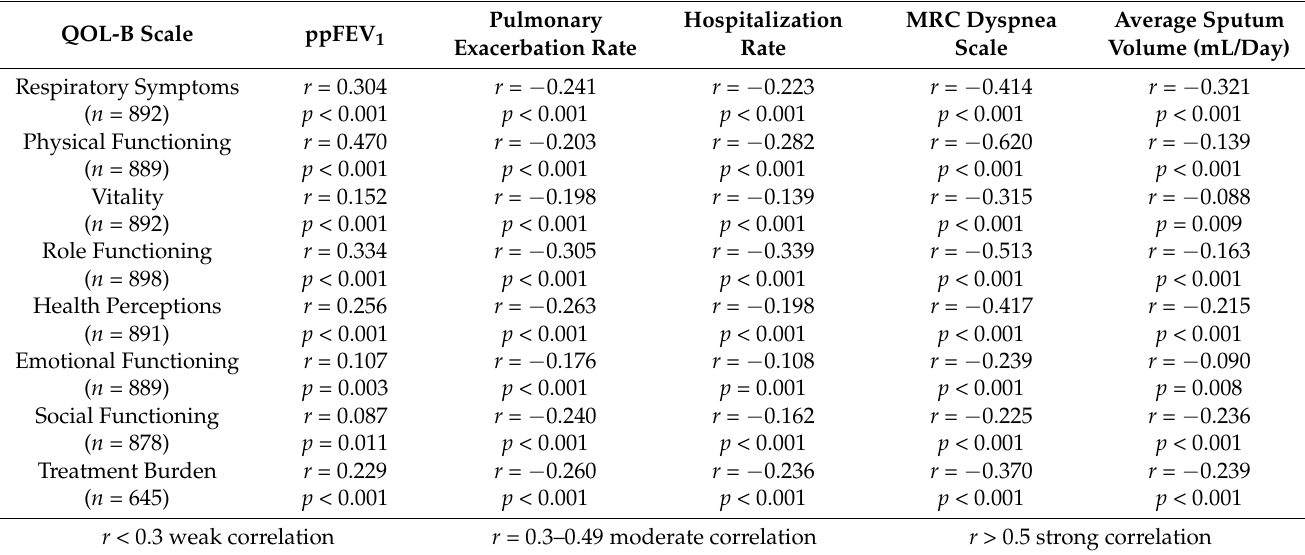
Table 6. Convergent validity: correlation between baseline QOL-B scores and measures of health status.